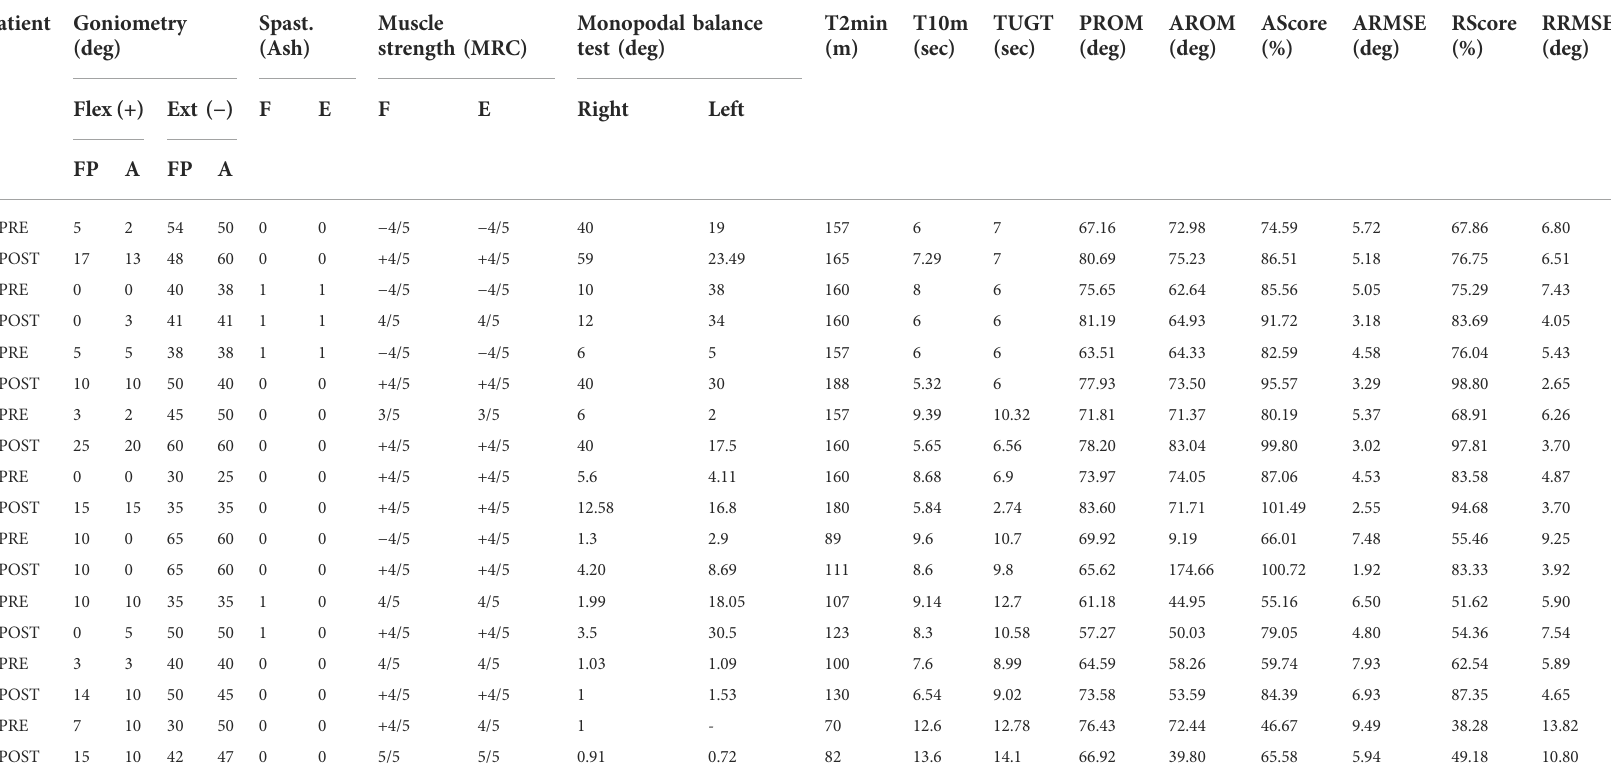
TABLE 3 Variables studied pre and post treatment. Patient Goniometry